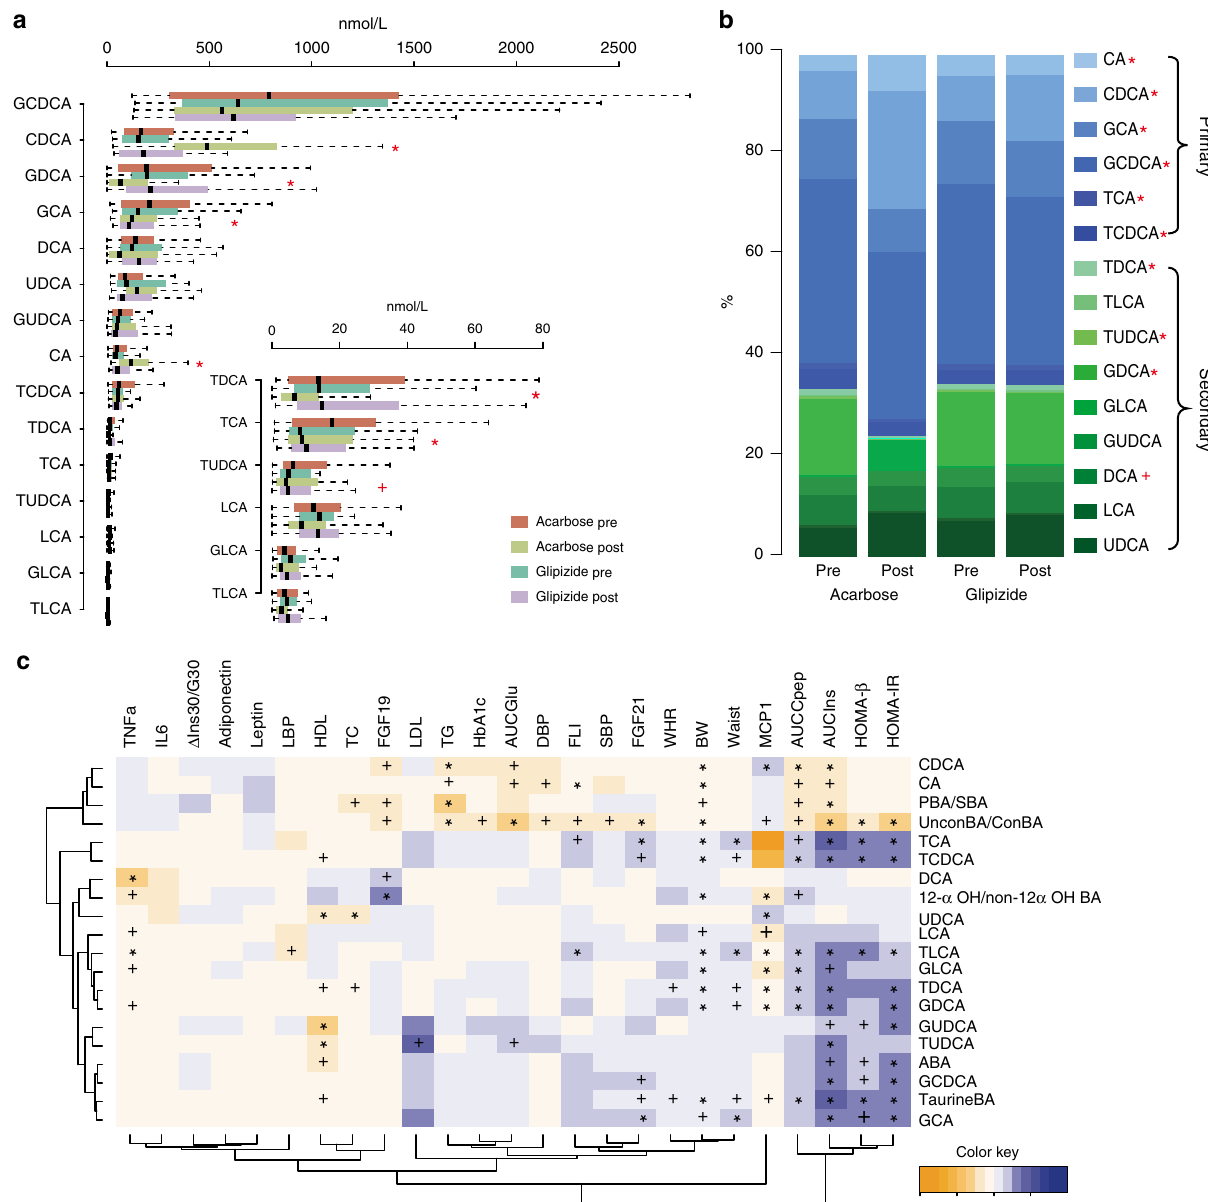
Fig. 2 Changes in bile acid composition in response to Acarbose treatment correlate with clinical outcomes. a Plasma levels of bile acids (BAs) before and after Acarbose and Glipizide treatments. Results are shown as boxes denoting the interquartile range between the fi rst and third quartiles. The line